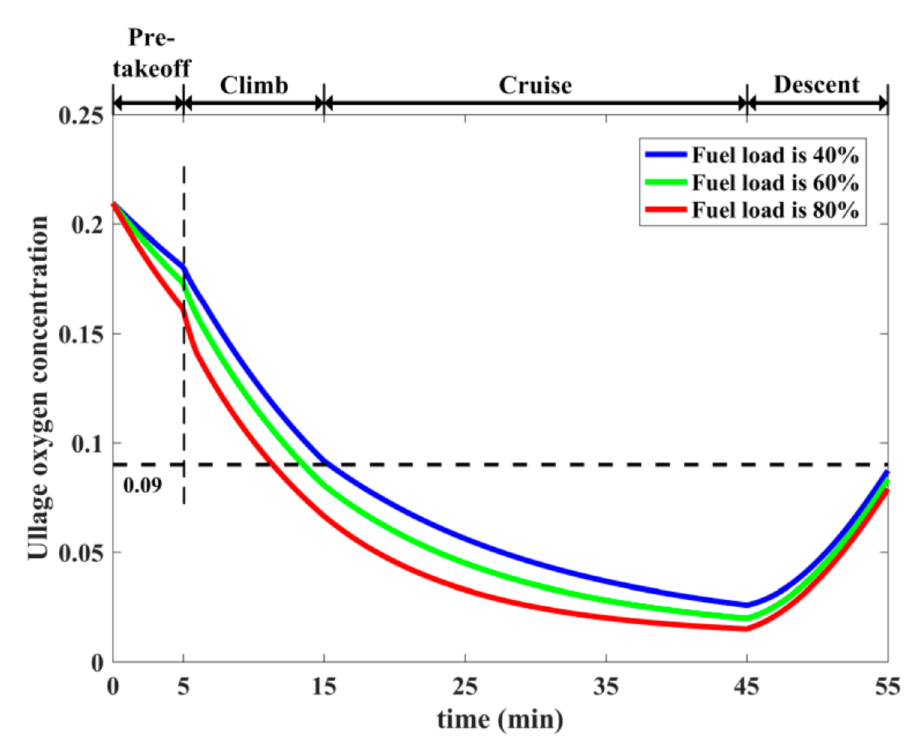
Figure 10. The ullage oxygen concentration regarding the fuel load of the tank, with the ground-based . v I = 0.2 m 3 /min, and k = 30%. inerting duration of 5 min, Table 8. The boundary condition of the ullage oxygen concentration analysis regarding the fuel load. Item Value Unit Ground-based inerting duration 5 min . v I 0.2 m 3 /min The volume inflow rate of NEA Scale coefficient k 30% - Fuel load 40%, 60%, 80%